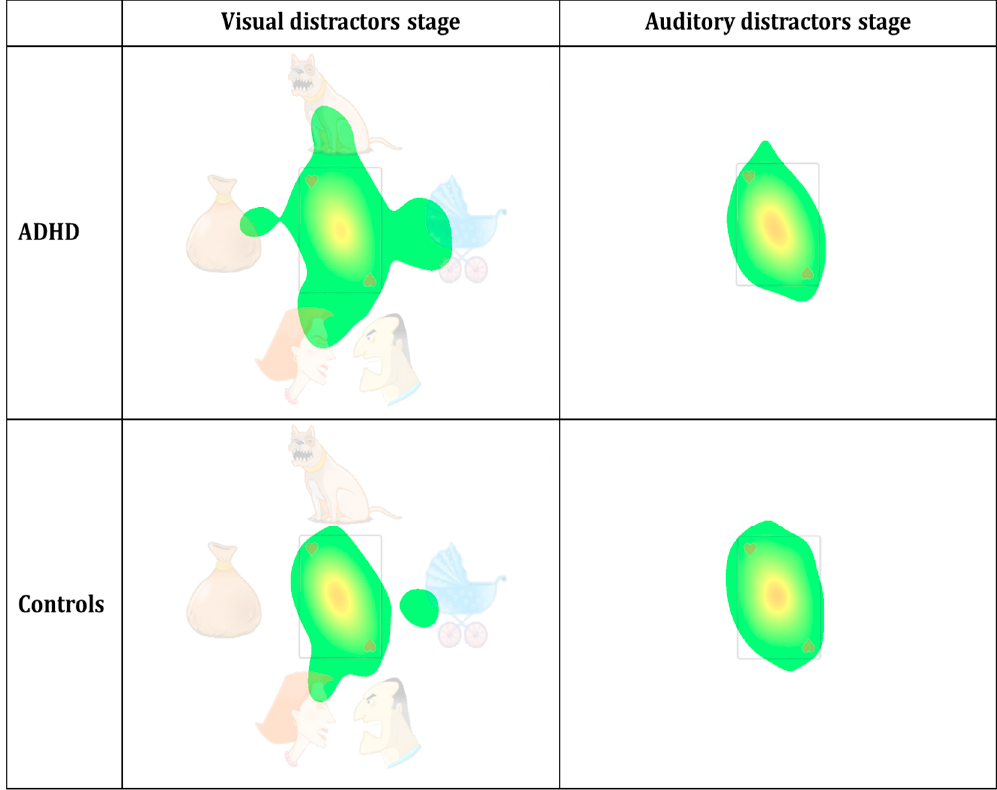
Figure 4. Heat maps of the eye distractibility scale, divided according to group (ADHD/controls) and MOXO-dCPT stages (visual/auditory).